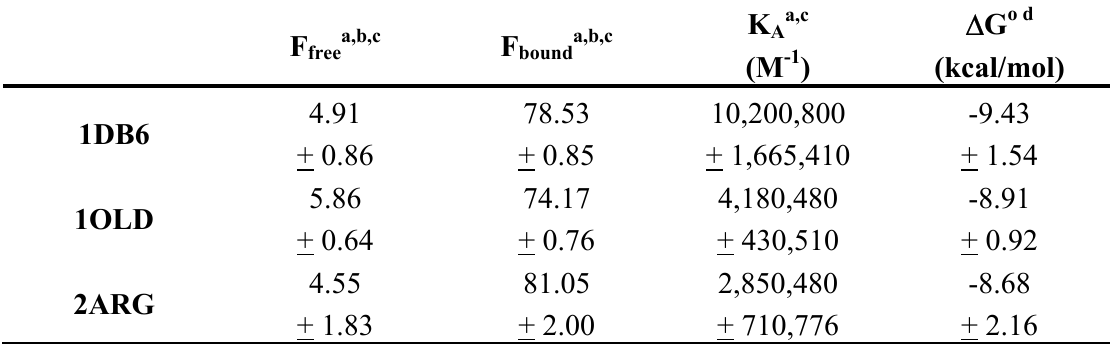
Table 3. Fitted parameters for the titration of ethidium by L-argininamide binding DNA